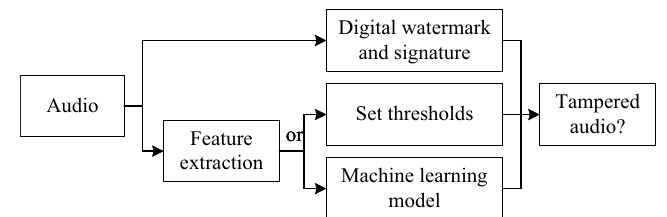
Fig. 1 Audio tampering detection